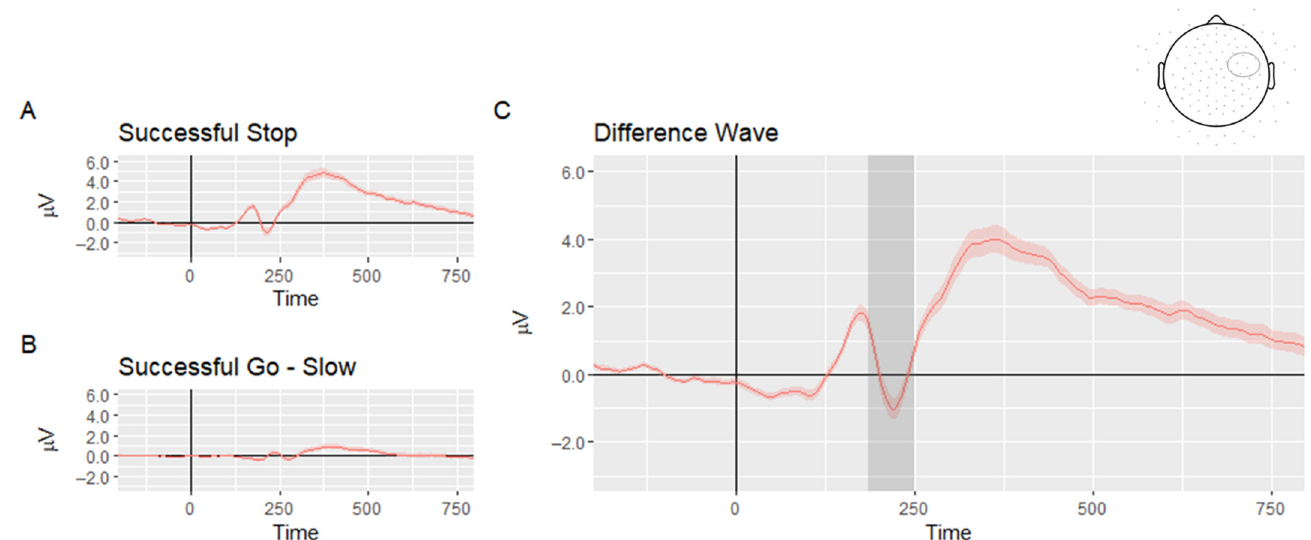
Figure 1. Grand average event-related potential waveforms of ( A ) successful stop ( B ) successful go of slow reaction times and ( C ) difference wave between a successful stop and successful slow go. Note . The shaded area represents standard error; the gray area delineates the N2 time window; the region of interest is marked with a circle on the electrode map at the top of the